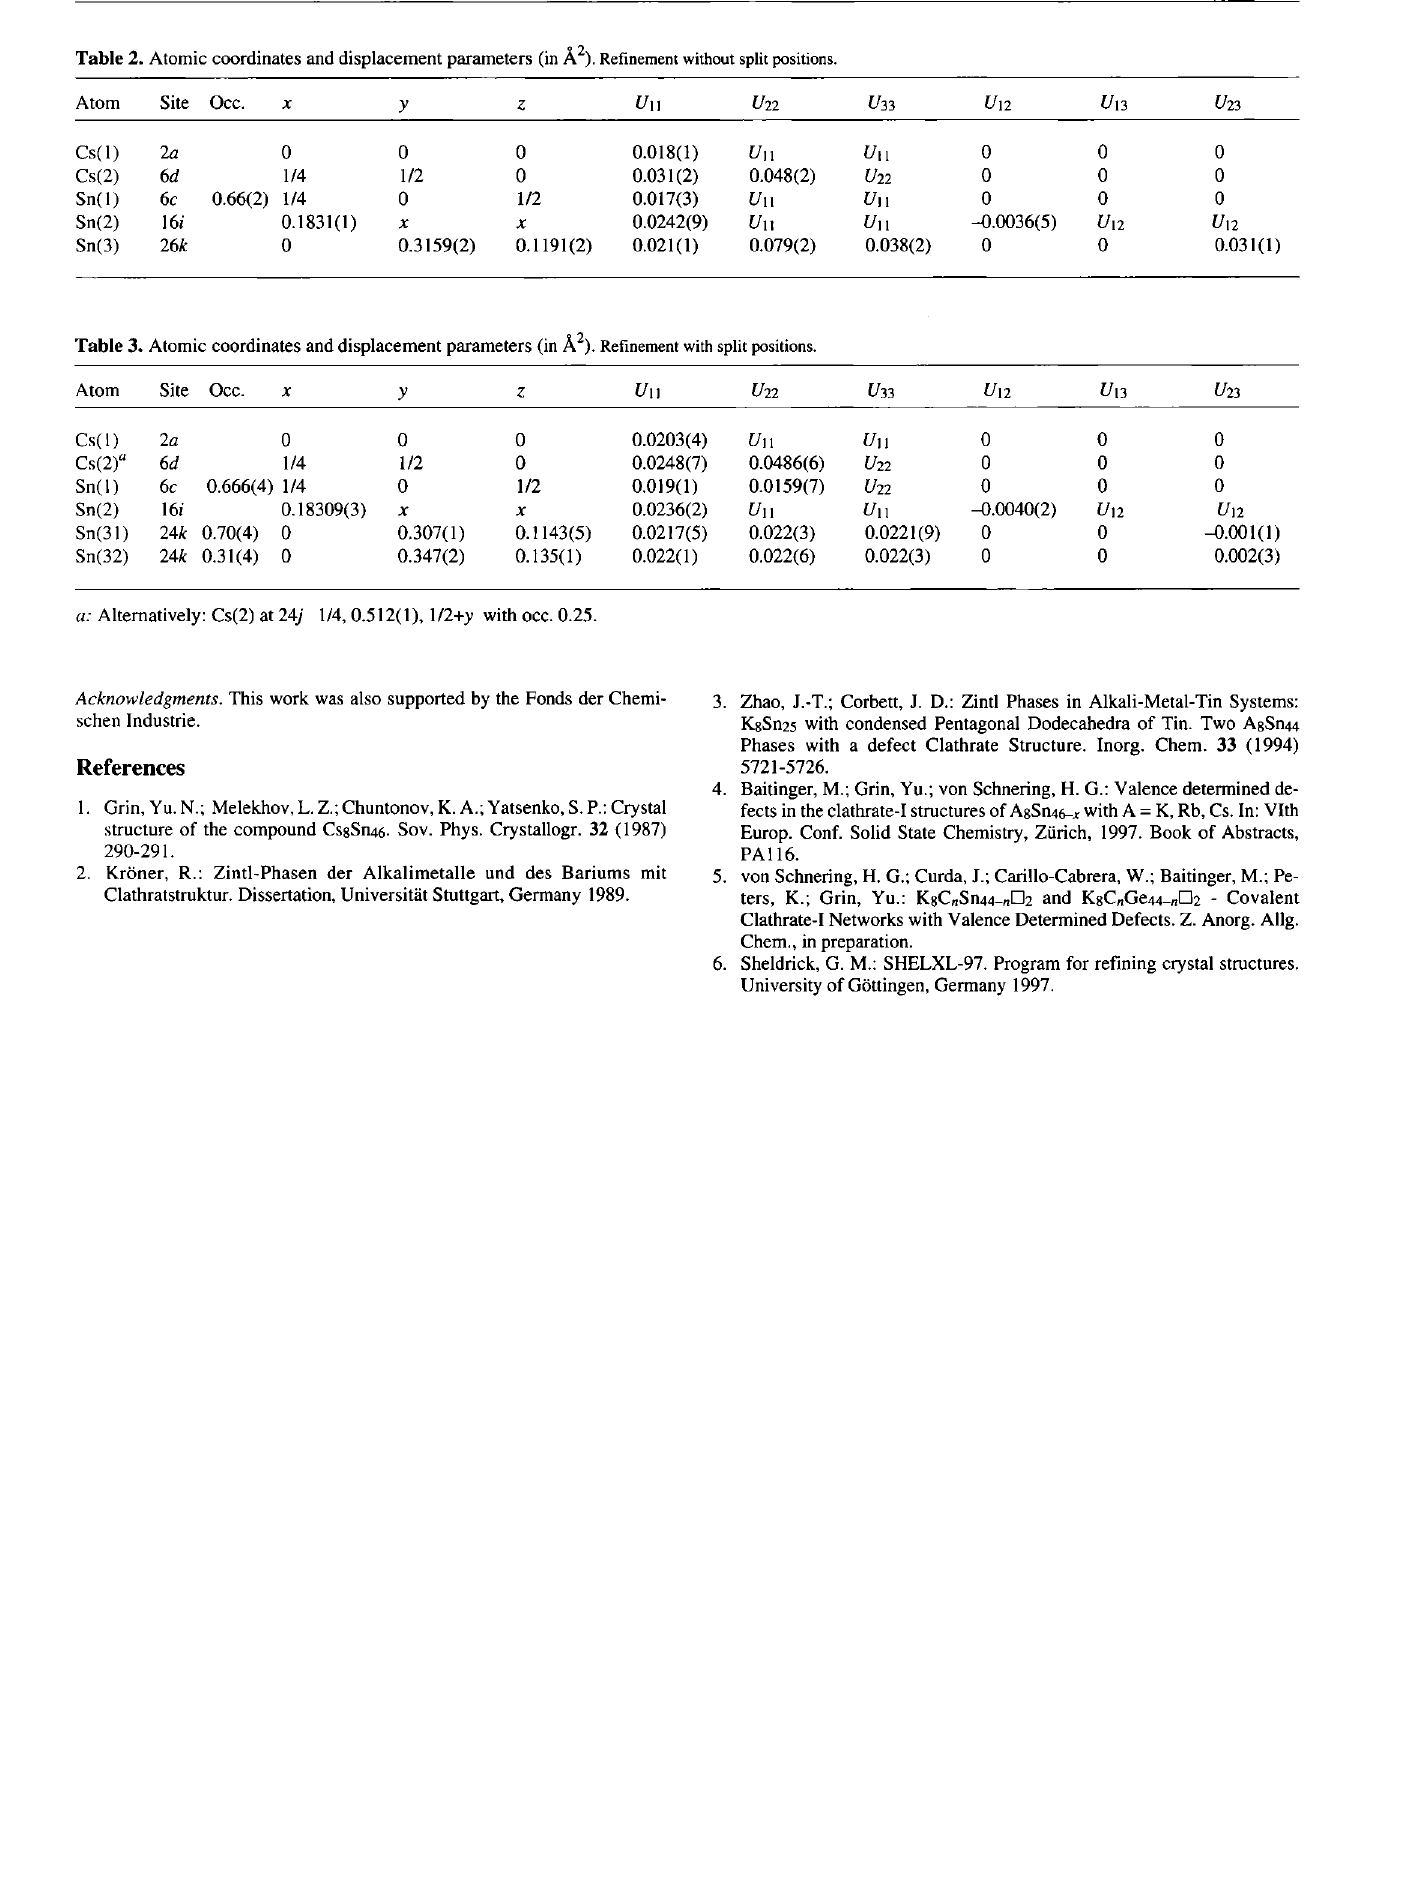
Table 3. Atomic coordinates and displacement parameters (in Ä 2 ). Refinement with split positions. Atom Site